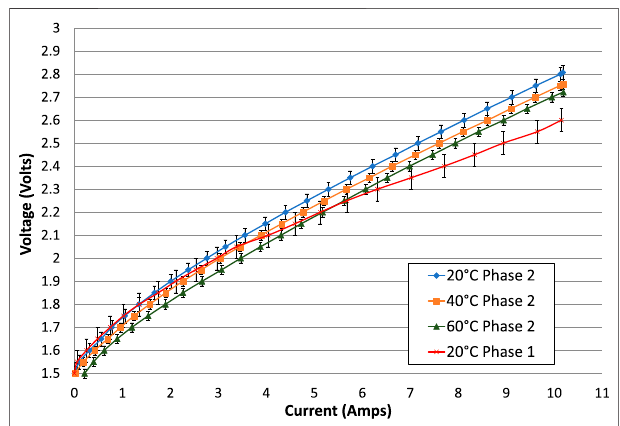
FIGURE 7 | Comparison of electrolysis tests at different temperatures and also compared with the equivalent test in phase 1, all with 1.25 mm spacers on each side of the membrane. The increasing and decreasing portionsoftheelectrolysistestshavebeenaveraged.Withtheexception of the 60 ° C test, the second (repeated) electrolysis test is shown.